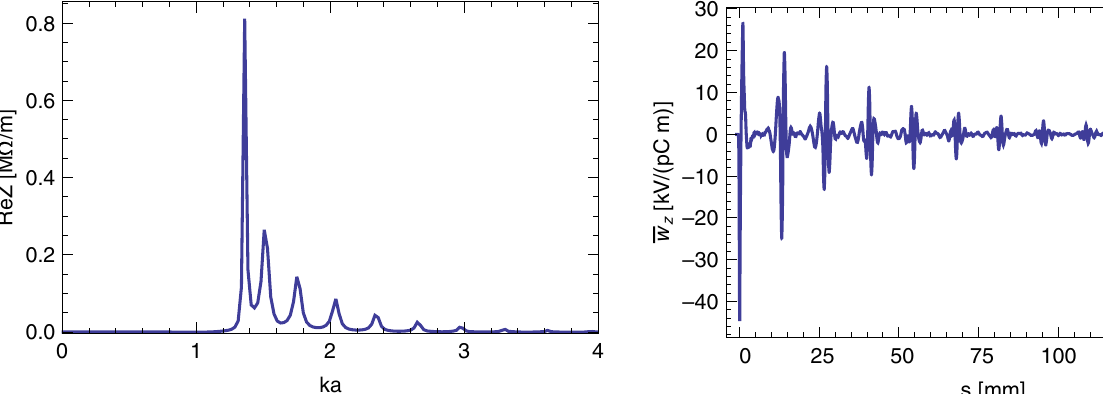
FIG. 13. The numerically obtained, longitudinal wake for a beam moving past a single-plate dechirper. Here the beam offset b ¼ 0 . 25 mm and dechirper length L ¼ 115 mm; the driving ¼ 100 μ m. Note that the wake is bunch is Gaussian with σ z normalized to structure length.